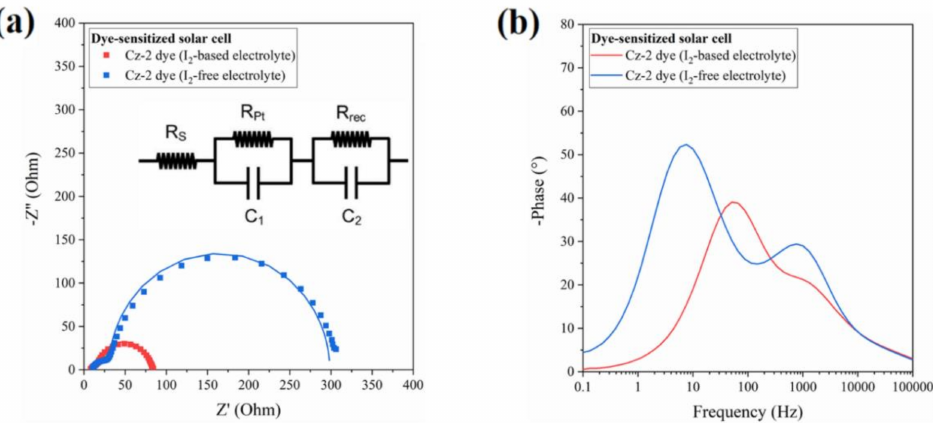
Figure 8. ( a ) Nyquist plots (inset the equivalent circuit) and ( b ) Bode phase diagrams for the solar cells that employed the working electrodes that were sensitized by the Cz-2 dye, using the I 2 -based or I 2 -free